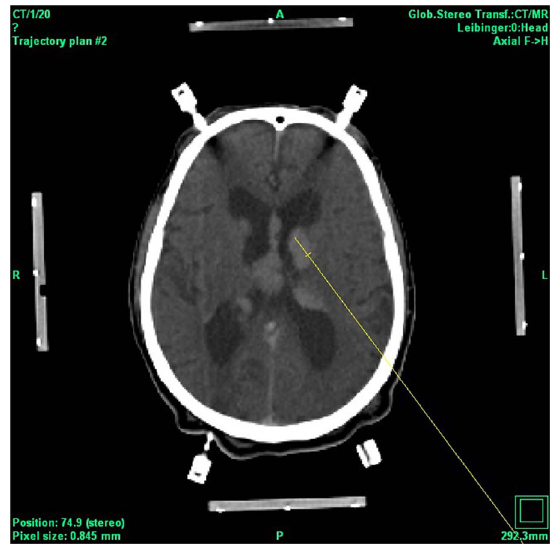
Fig. 2 An illustrative case. Screen capture from a preoperative CT stereotactic brain biopsy planning. Histological diagnosis was multiple primary brain lymphomas